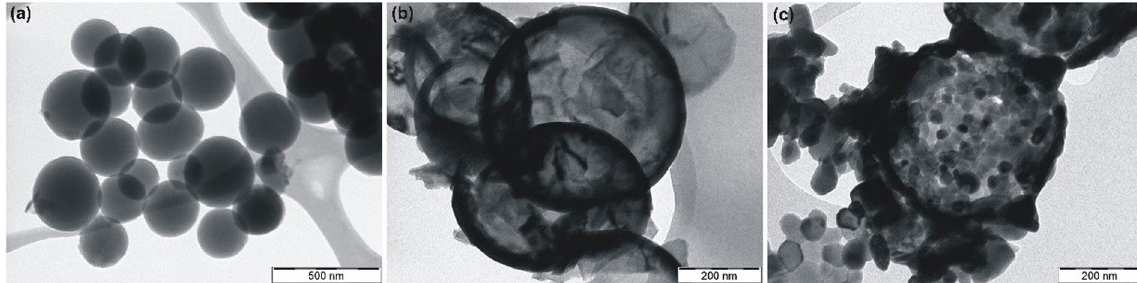
Figure 7. TEM images of the specimens. ( a ) C-TiO 2 -80C, ( b ) H-TiO 2 -250C and ( c ) H-ZnO-250C.